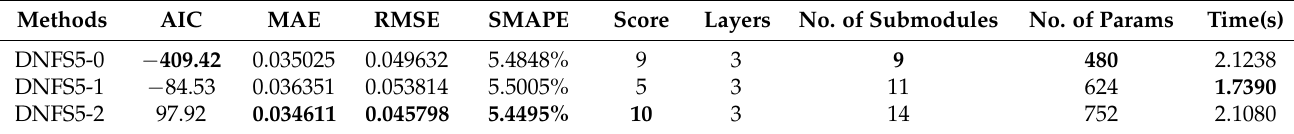
Table 6. The performance of DNFSs with different shared inputs on Test Dataset No. 2.